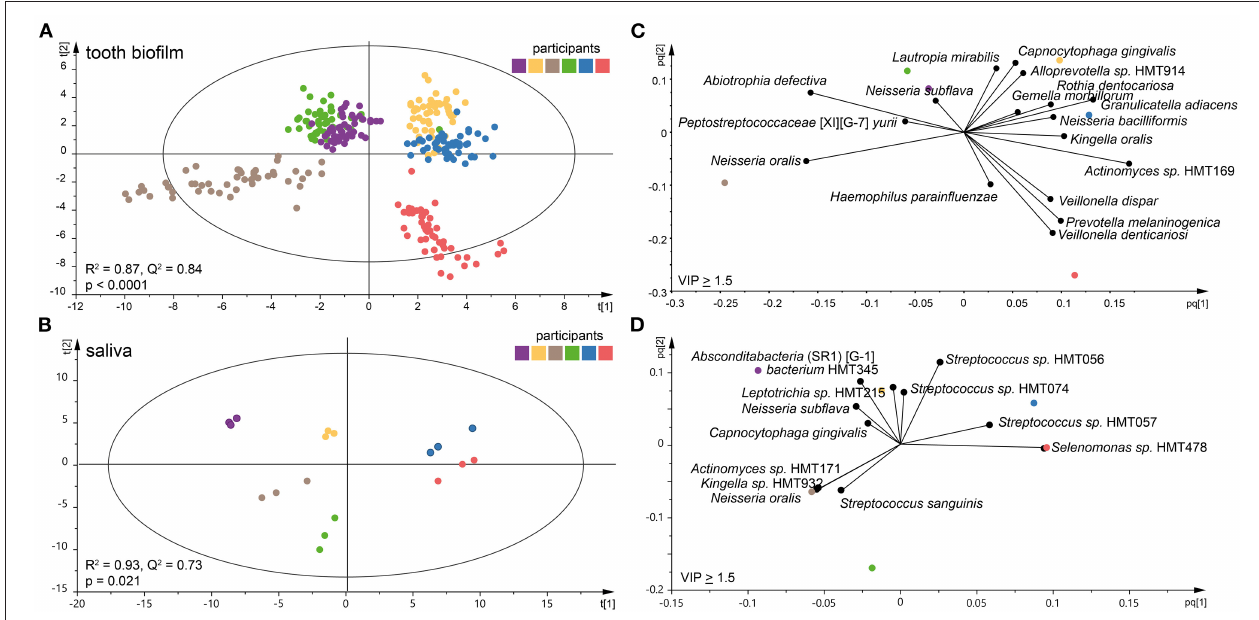
FIGURE 2 | Clustering of the six participants by tooth biofilm and saliva microbiota samples. Orthogonal partial least squares discriminant analysis (OPLS-DA) derived score scatter plots for (A) tooth biofilm samples from all 16 tooth regions and three accumulation times and (B) saliva samples from three accumulation times. The plots show group separation by discrimination component 1 ( t [1]) and 2 ( t [2]). OPLS-DA derived loading scatter bi-plots for (C) tooth biofilm and (D) saliva in which the x -loading [ p ] and y -loading [ q ] for the first [ pq 1] and second [ pq 2] predictive components are